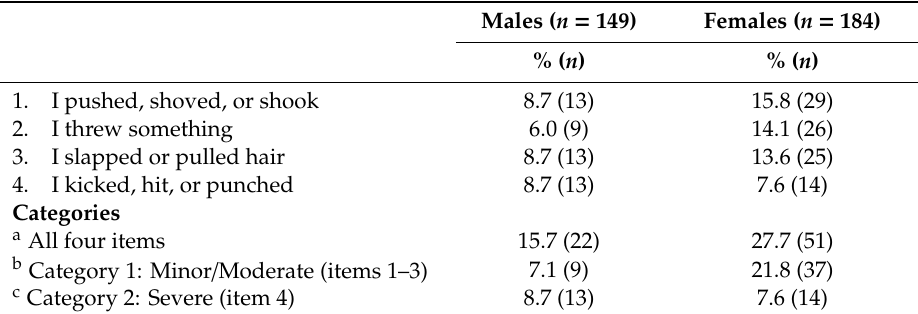
Table 2. Prevalence of physical TDV perpetration by item and three